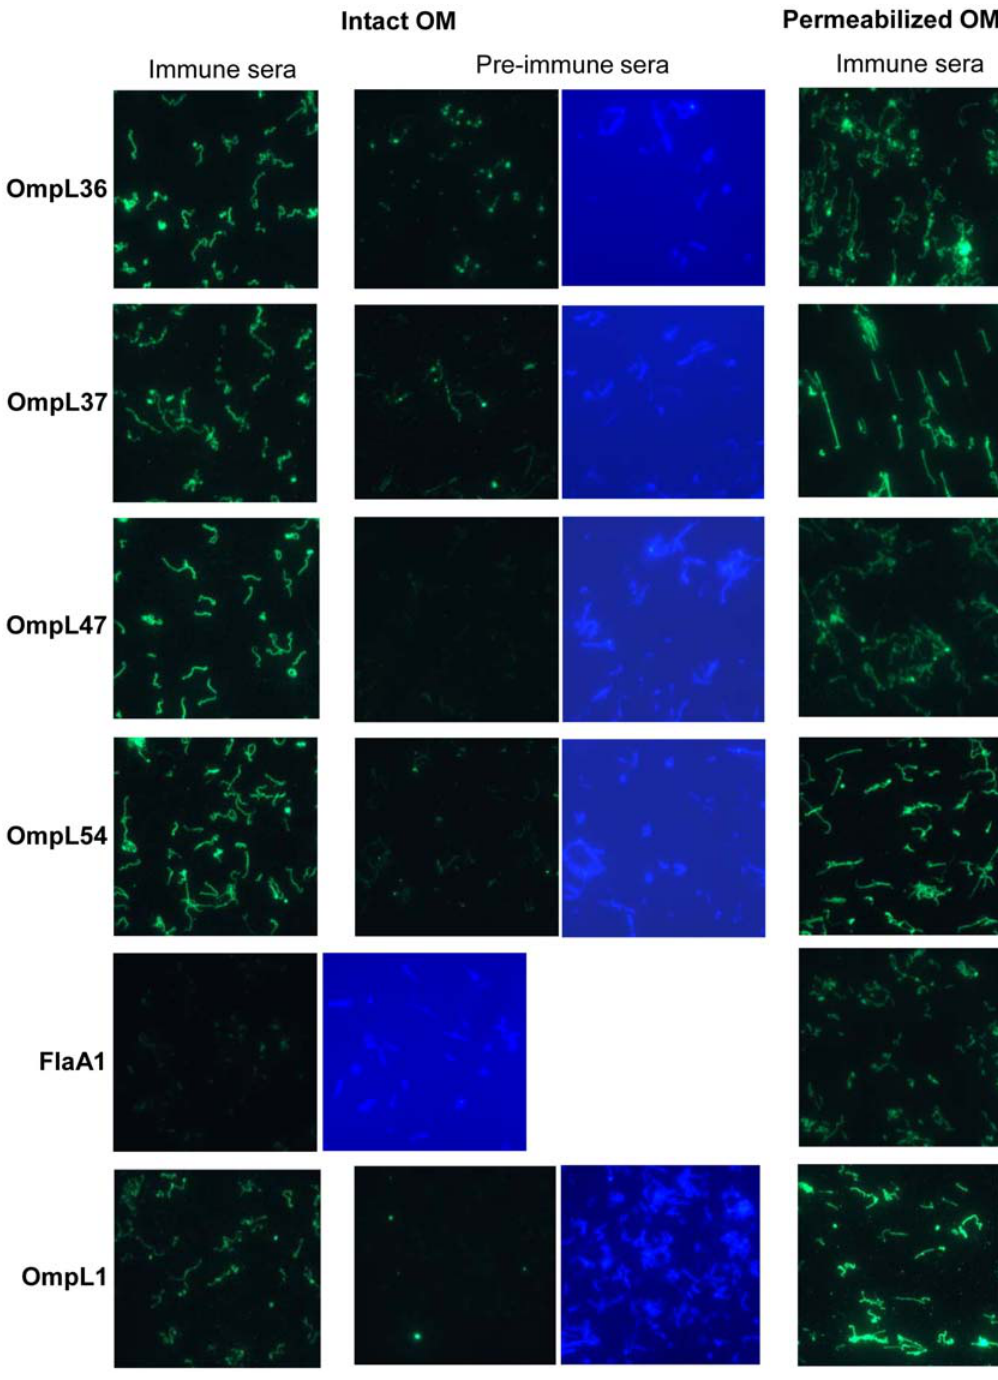
Figure 3. Surface localization OmpL36, OmpL37, OmpL47, OmpL54, and OmpL1 by surface immunofluorescence assay (IFA). Intact or membrane-permeabilized spirochetes were probed with immune and pre-immune sera (when utilized). Binding of rabbit sera to leptospires were detected with Alexa Fluor 488 conjugated goat anti-rabbit IgG fragments. A DAPI counterstain was used to monitor the presence of spirochetes. The identities of individual proteins recognized by the particular antiserum are indicated on the left. All images are taken after 4 sec long